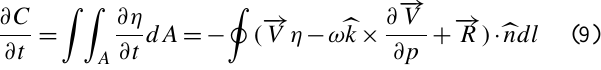
Fig. 16. The vertical distribution of the 2 ◦ × 2 ◦ box averages of (a) relative vorticity (unit: 10 − 5 s − 1 ), (b) divergence (unit: 10 − 5 s − 1 ), (c) relative humidity (unit: %) and (d) θ e (unit: K) following the moving pouch center (defined by the intersection of the local critical surface and the trough axis) from Hour 48 to Hour 120. The ordinate is pressure (hPa) and the abscissa is time (hour). Values below the surface are masked out between hours 87 to 120.